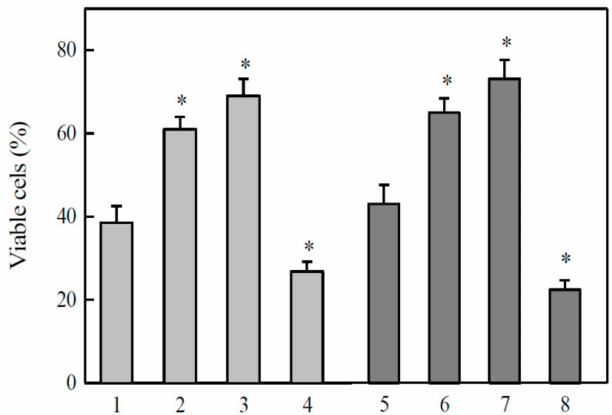
Figure 5. E ff ects of antioxidants and 1,3-bis(2-chloroethyl)-1-nitrosourea (BCNU) on the cytotoxicity of TPZ and 9,10-phenanthrene quinone in MH22a cells. 40 µ M TPZ (1–4), 5.0 µ M 9,10-phenanthrene quinone (5–8), additions: none (1,5), + 300 µ M desferrioxamine (2,6), + 3.0 µ M N,N’-diphenyl-p-phenylene diamine (DPPD) (3,7), + 20 µ M BCNU (4,8). Additions of DPPD, desferrioxamine and BCNU did not a ff ect the cell viability. n = 3, p < 0.02 for 1 against 2–4, and for 5 against 6–8 (*). Cell viability in control experiments, 98.5 ±